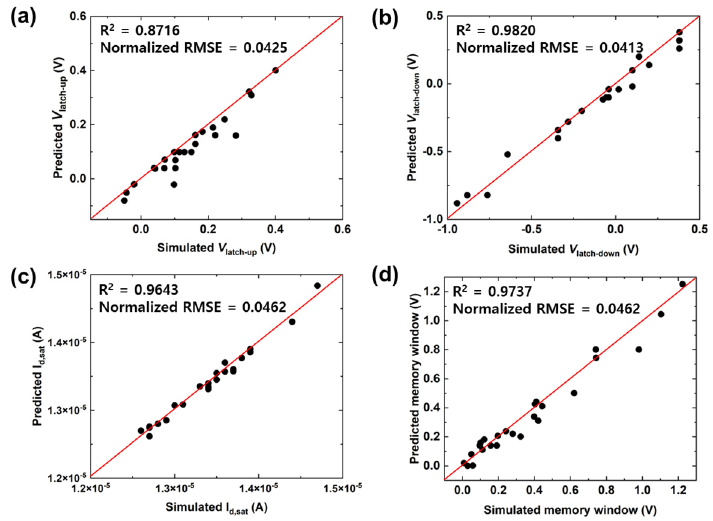
Figure 4. Scatter plots showing the prediction of ( a ) V latch-up , ( b ) V latch-down , ( c ) I d,sat , and ( d ) memory window, which were the major extracted parameters from the predicted I DS - V GS transfer curves. V latch-up and V latch-down were defined as the gate voltages at I DS = 10 − 9 A. I d,sat was defined as the drain current at V GS = 3.0 V. The memory window was defined as the voltage difference between V latch-down and V latch-up .